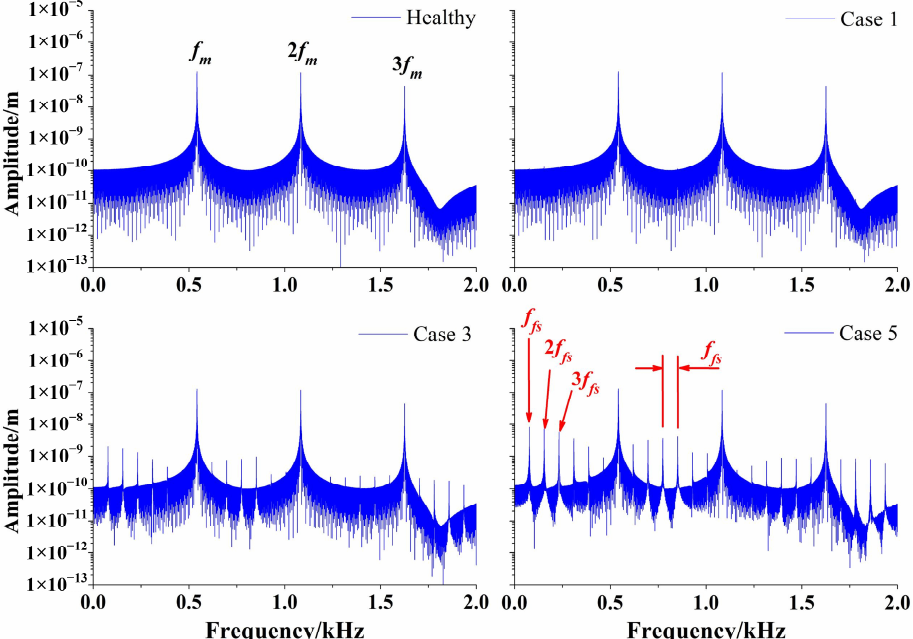
Figure 20. Frequency spectrums of torsional vibration responses on the sun gear.